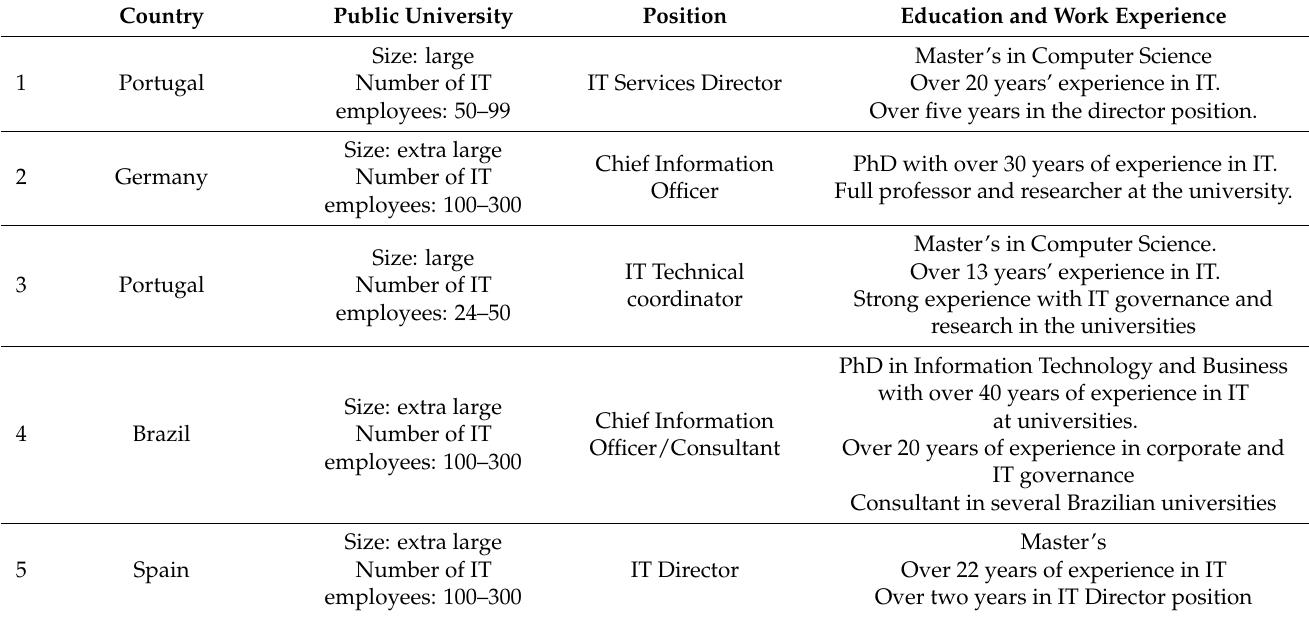
Table 5. Details about the interviews in the